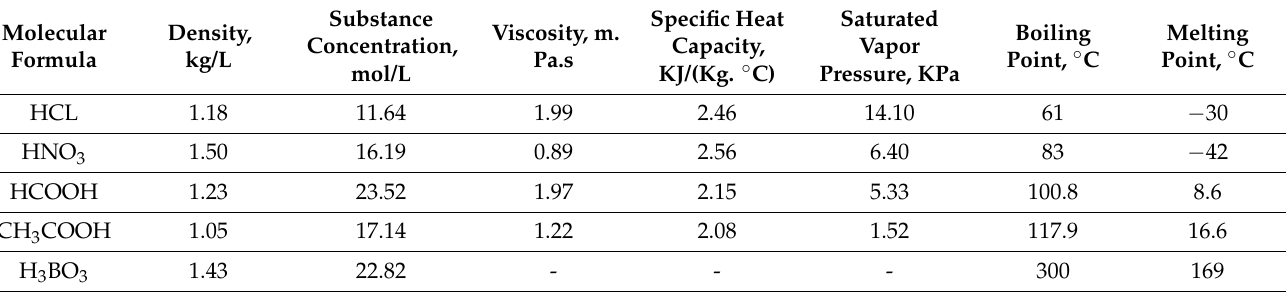
Table 4. Physical properties of acidic